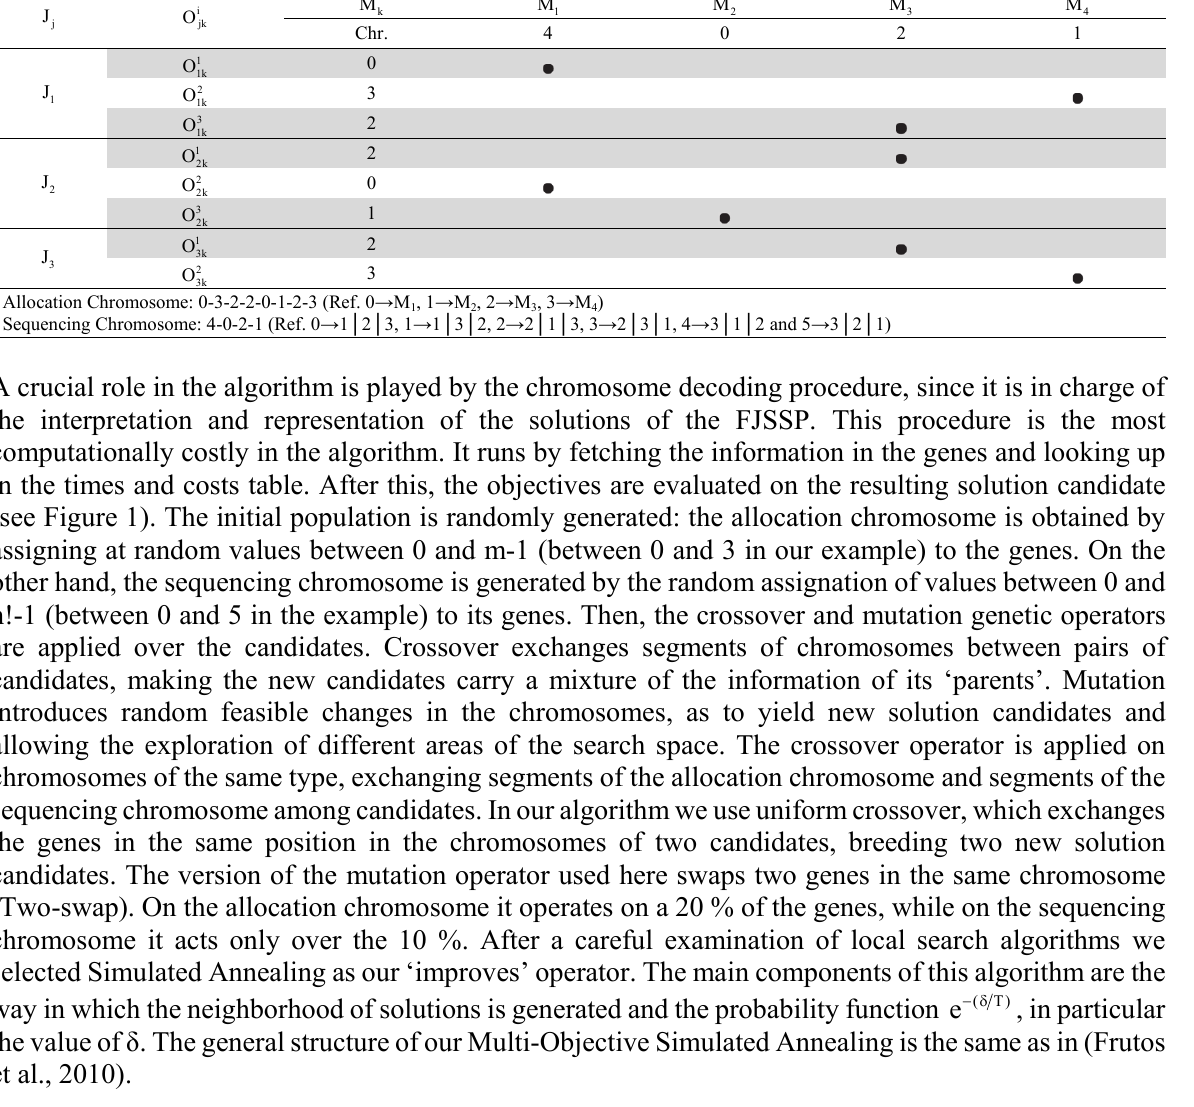
Allocation and Sequencing Chromosomes MF01 / Problem 3 × 4 with 8 operations